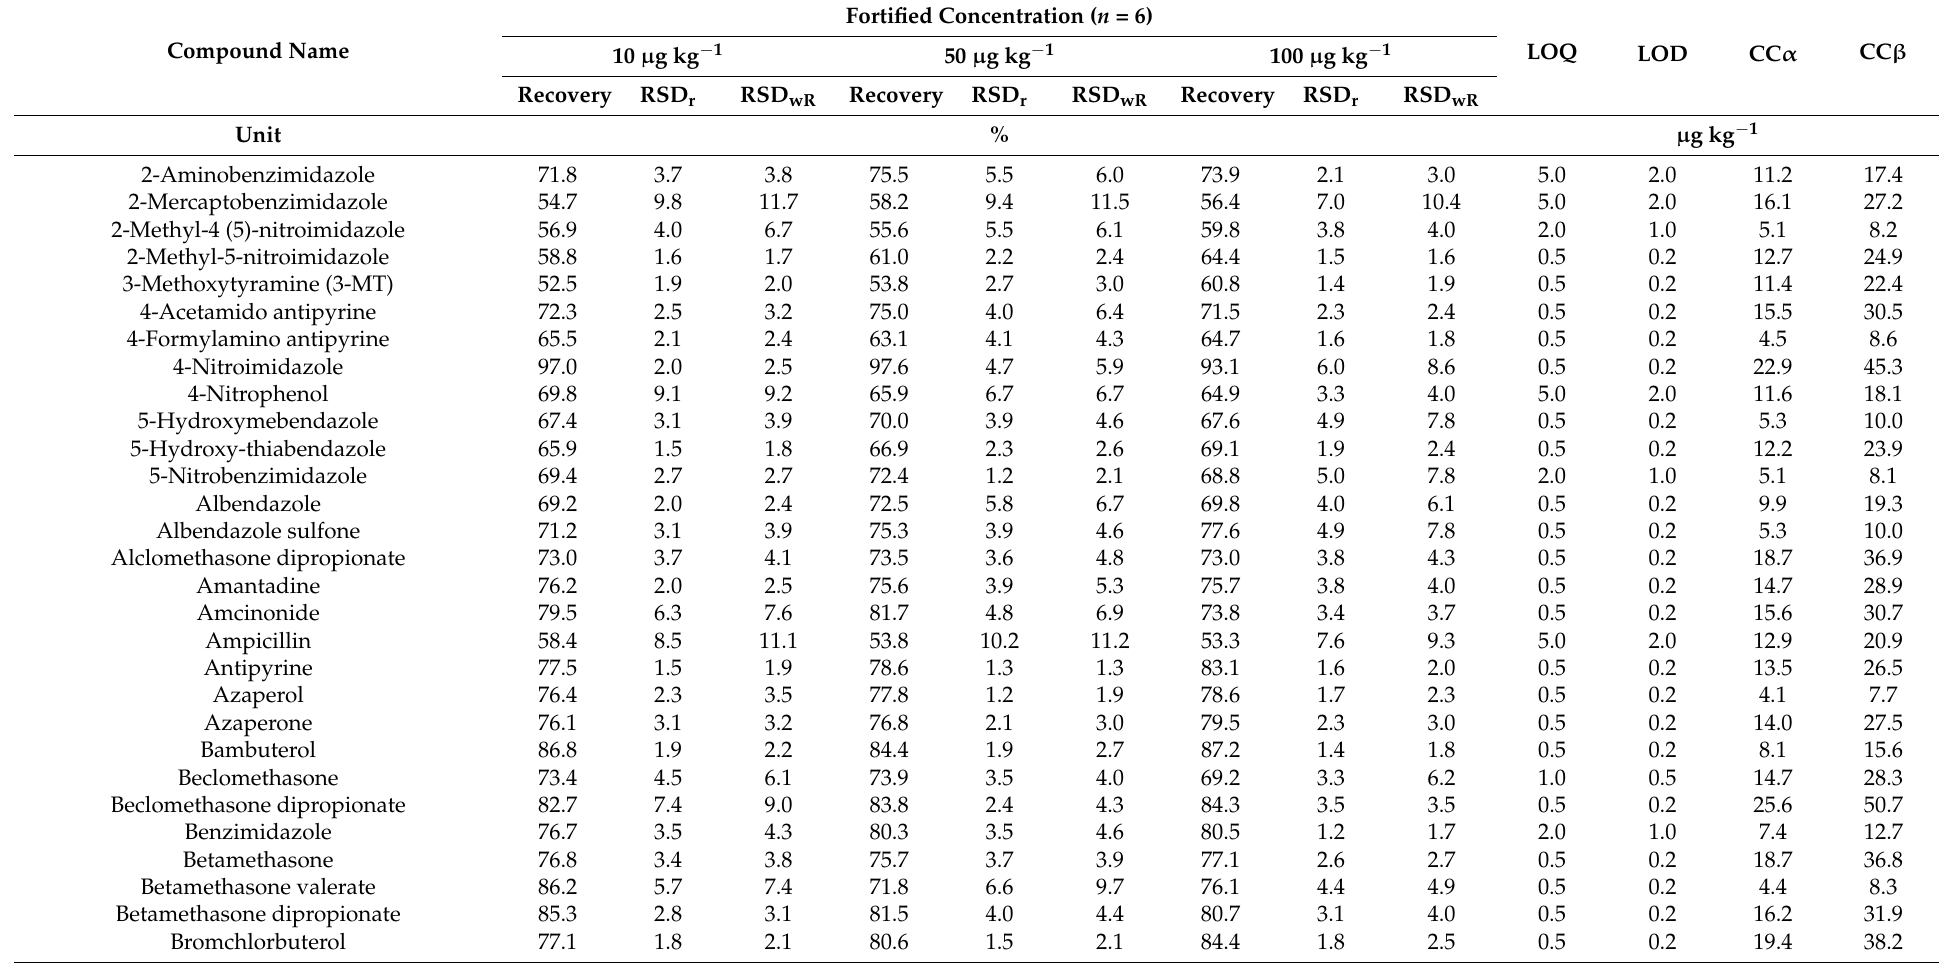
Table 1. The results of method validation for determination of 244 chemical contaminants in